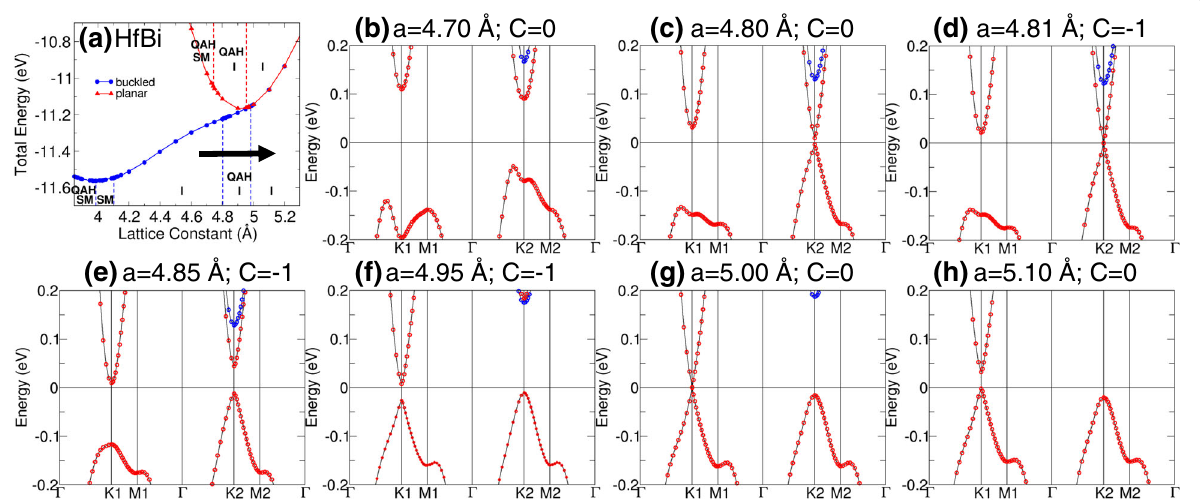
Fig. 4 Phase transition after varying the lattice constant. a Phase diagram of buckled HfBi. The arrow shows the path of the transition. b – h The band structure transition as the lattice constant was increased from 4.7 to 5.1